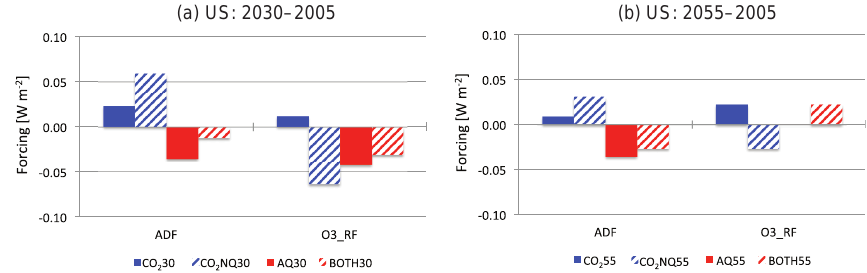
Figure 14. Impact of climate response due to emissions on US averaged radiative forcings in (a) 2030 and (b) 2055 relative to 2005. Note that BC albedo forcing is added into aerosol direct forcing